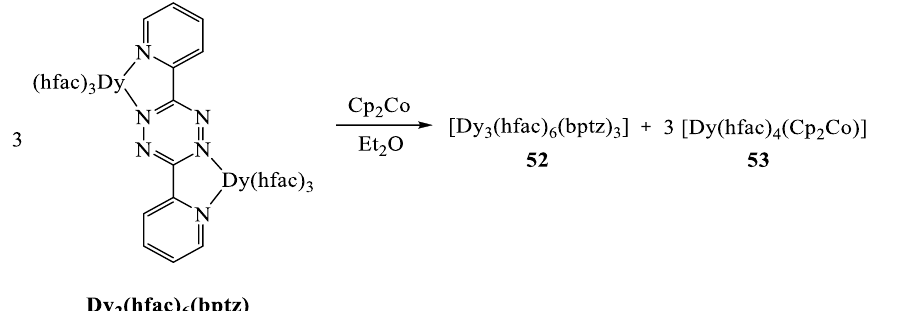
Figure 27. Molecular structure of 53 [96]. Hydrogen atoms have been omitted, some ligands groups